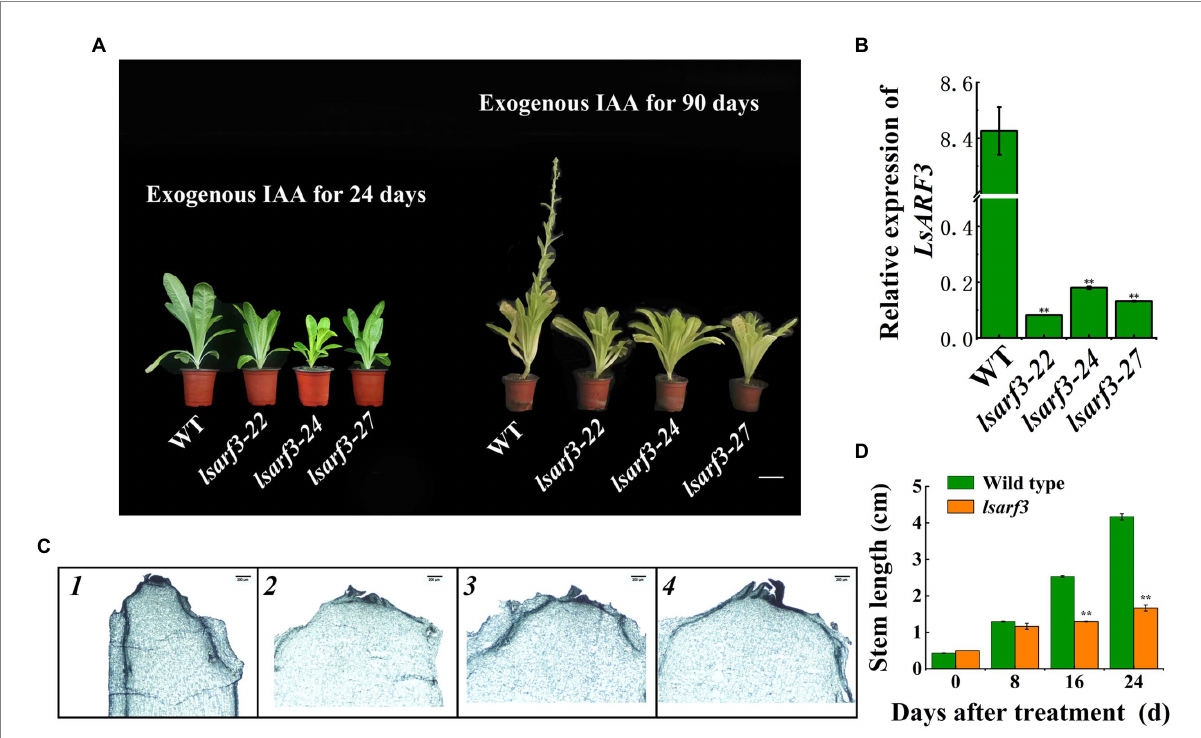
FIGURE 4 Effects of exogenous IAA on bolting and LsARF3 expression in lsarf3 mutants. (A) Plant morphological character after exogenous IAA application. (B) LsARF3 gene expression after exogenous IAA application for 24 days. (C) Flower bud differentiation of stem apex after exogenous IAA application for 24 days. (D) Stem length change after exogenous IAA application. Significant differences were tested by Student’s t -test (**indicates p <